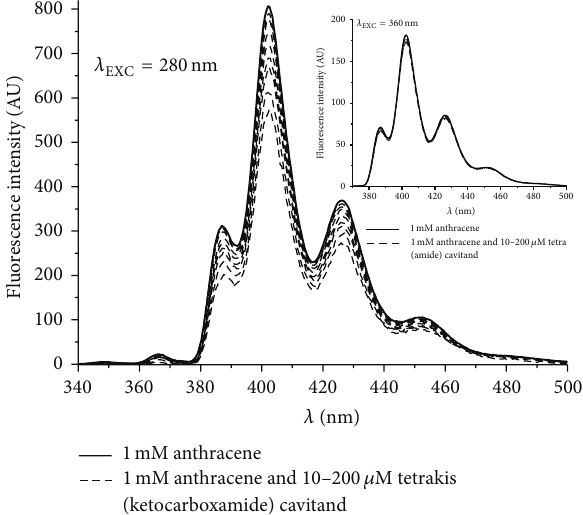
Figure 5: Corrected fluorescence spectra of anthracene in the absence and in the presence of different concentrations (10–200 𝜇 M) of the cavitand quencher ( 1 ). The excitation wavelength was 𝜆 = 360 nm in the graph on the upper- 280 nm for the main and 𝜆 EXC right